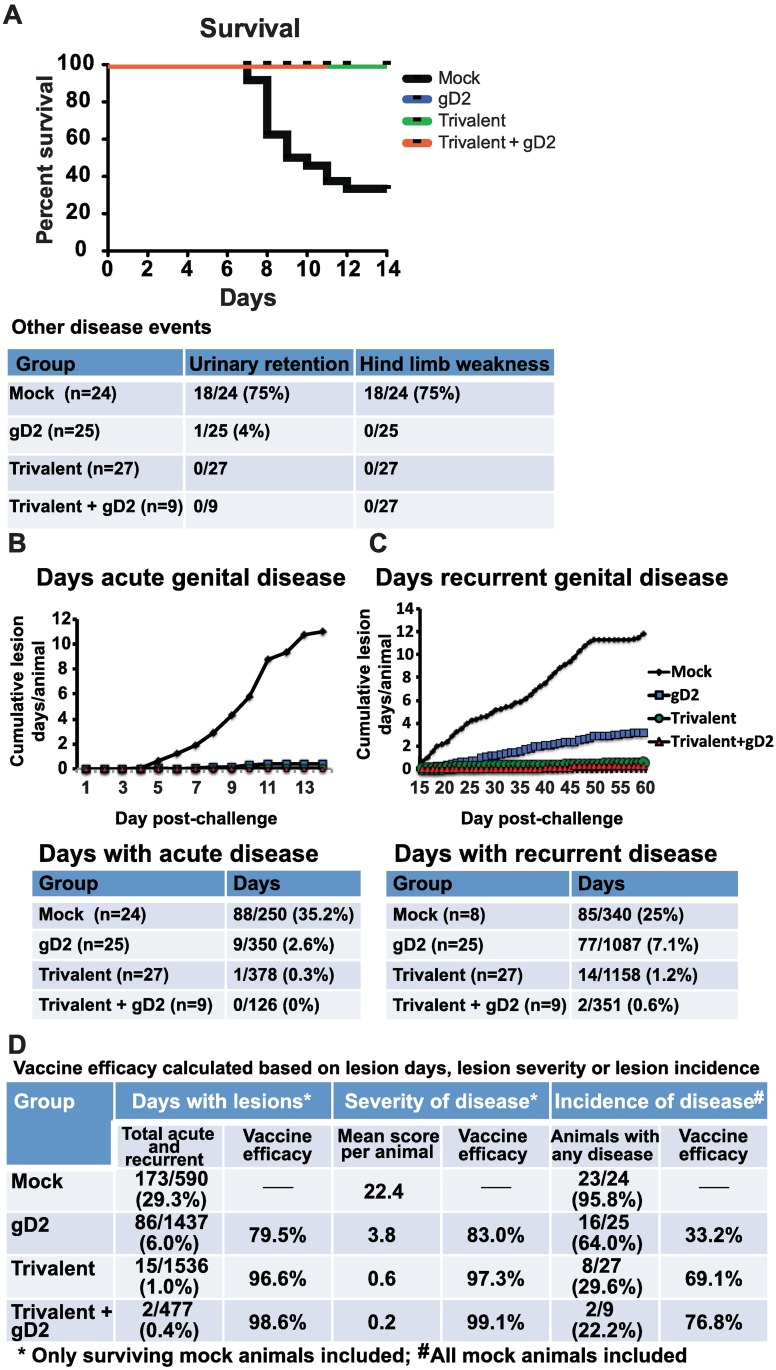
Survival and genital lesions in immunized guinea pigs after intravaginal challenge.(A) Survival curves. The table shows urinary retention and hind limb weakness during the first two weeks. (B) Days with acute genital lesions. (C) Days with recurrent genital lesions. Tables below (B) and (C) show the numbers used to generate the graphs. (D) Vaccine efficacy of gD2, trivalent, or trivalent + gD2 compared with mock. P values for (A) were calculated using Prism software by linear regression, while P values for (B-D) were calculated using Fisher’s exact test, except that severity of disease was calculated by Student’s t-test.